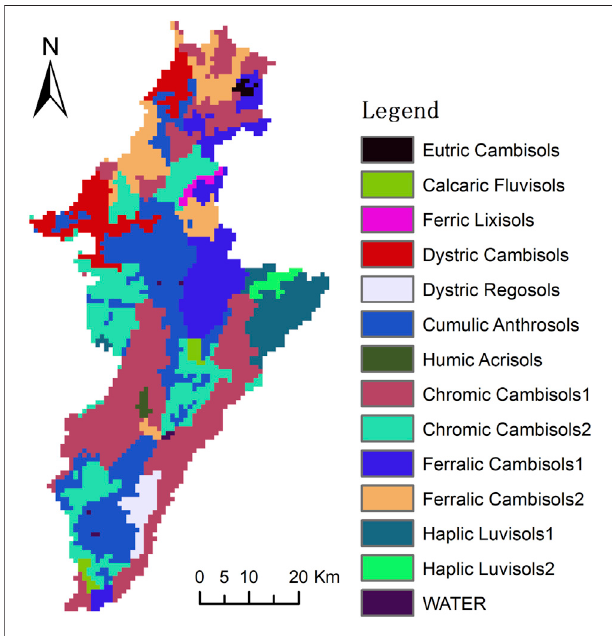
FIGURE 2 | Classi fi cation of land cover types (year 2015). FIGURE 3 | Classi fi cation of soil